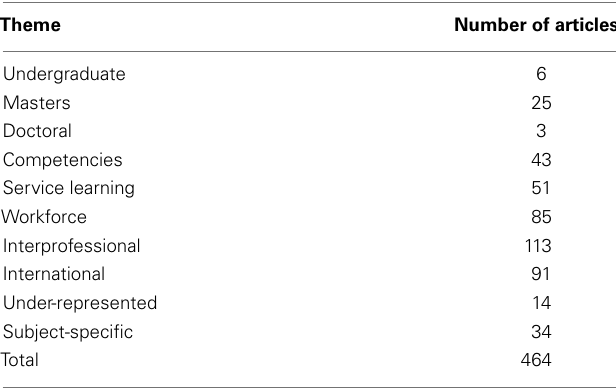
Table 1 |Themes of articles listed in Pubmed pertaining to